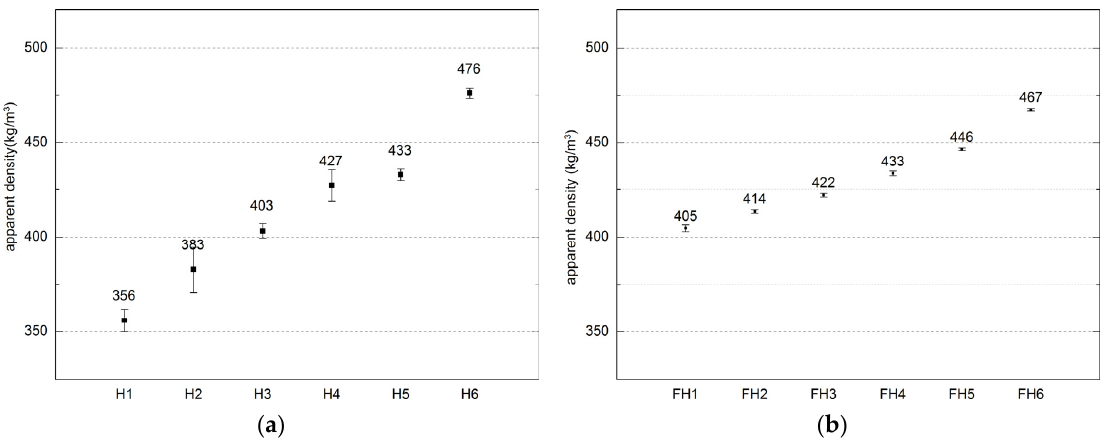
Figure 8. Apparent density of composites (error bars mean standard deviations of apparent density) : ( a ) Series 1, ( b ) Series 2.